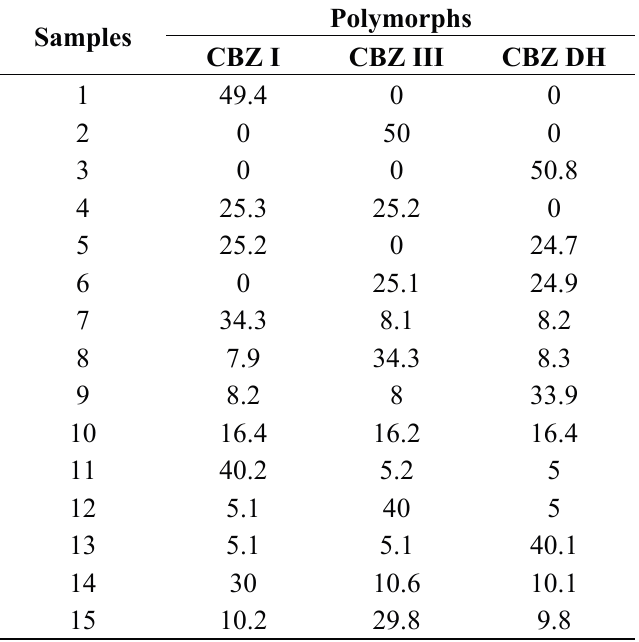
Table 2. Amount of CBZ in mg of each polymorph for the calibration (1–10) and validation (11–15)